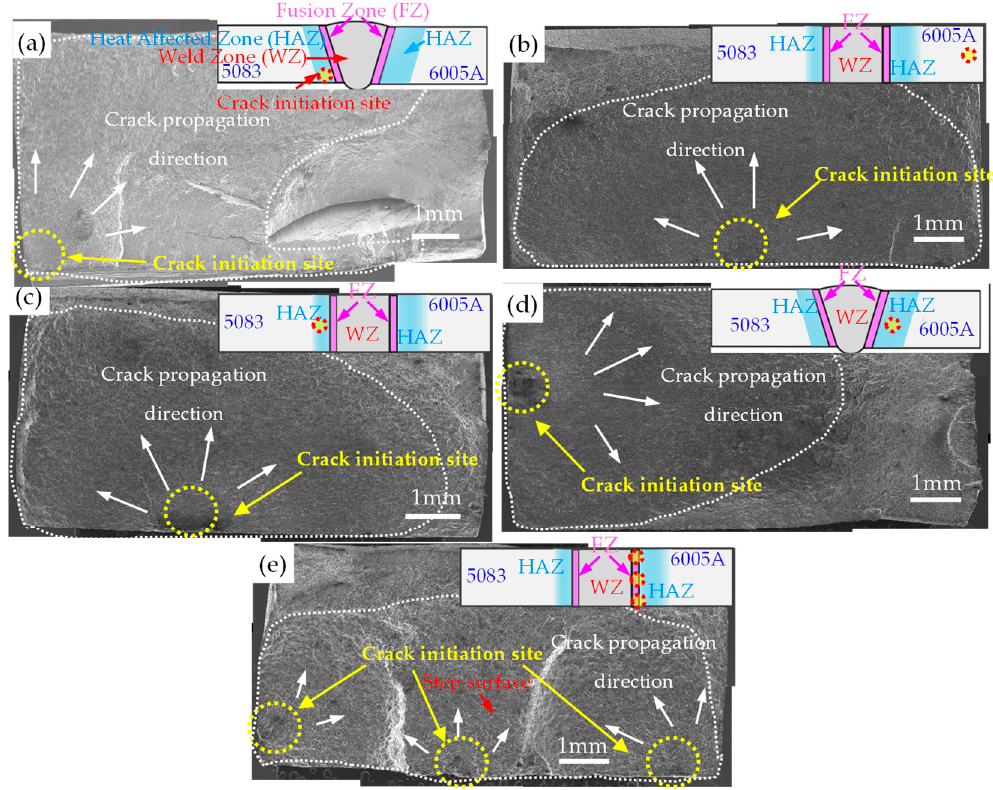
Figure 5. SEM images of fatigue fractures of the 5083/6005A welded joints after corrosion in the 3.5% NaCl + 0.01 mol/L NaHSO 3 solution: ( a ) uncorroded; ( b ) 3 days; ( c ) 7 days; ( d ) 15 days; ( e ) 30 days.